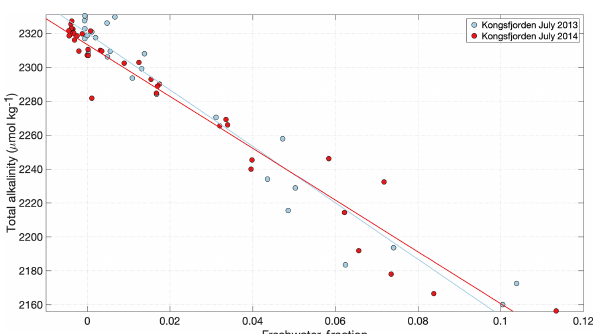
Figure 8. Total alkalinity in Kongsfjorden during the meltwater sea- son (data from Fransson and Chierici, 2019). A decline in alkalin- ity is evident with increasing freshwater fraction in response to the low alkalinity concentrations in glacier discharge. Freshwater frac- tion was calculated using an average marine salinity endmember of 34.96; hence some slightly negative values are calculated in the outer fjord associated with the higher salinity of unmodified At- lantic water. Linear regression details are shown in Table